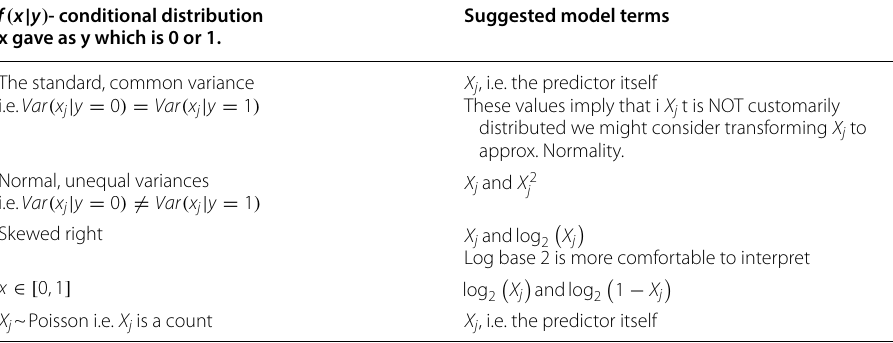
Table 2 Univariate Considerations [15] f ( x | y ) - conditional distribution x gave as y which is 0 or